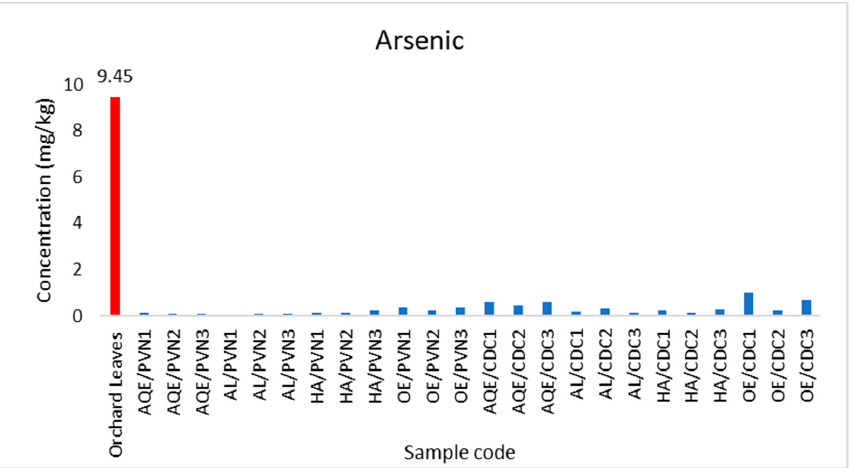
Figure 6. The graph shows As concentrations (mg/kg) in extract samples with standard reference material NIST 1571 Orchard leaves. material NIST 1571 Orchard